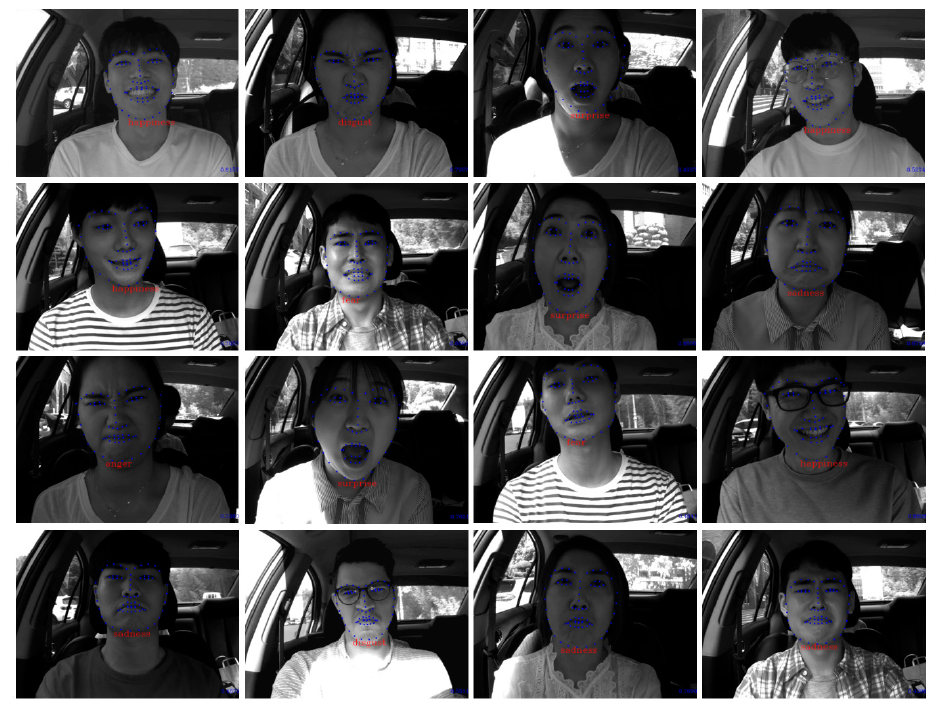
Figure 7. Facial expression recognition results in a moving vehicle using the KMU-FED database.